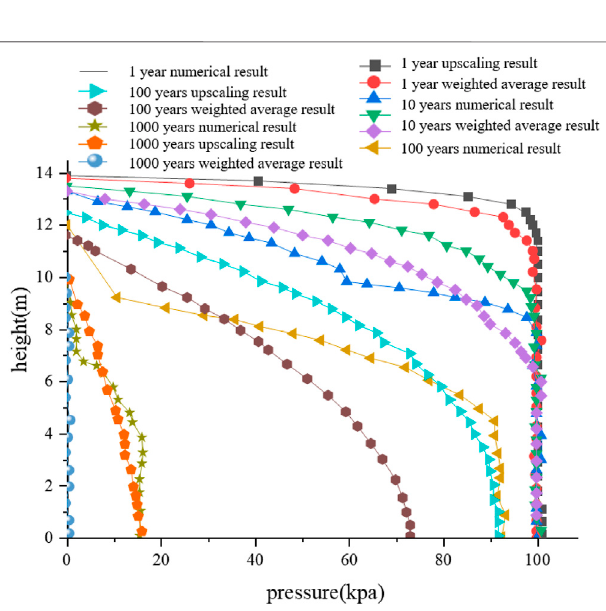
FIGURE 12 | Overpressure evolution comparison between the two upscaling methods (weighted average and the new method) and numerical results for 1, 10, 100, and 1,000